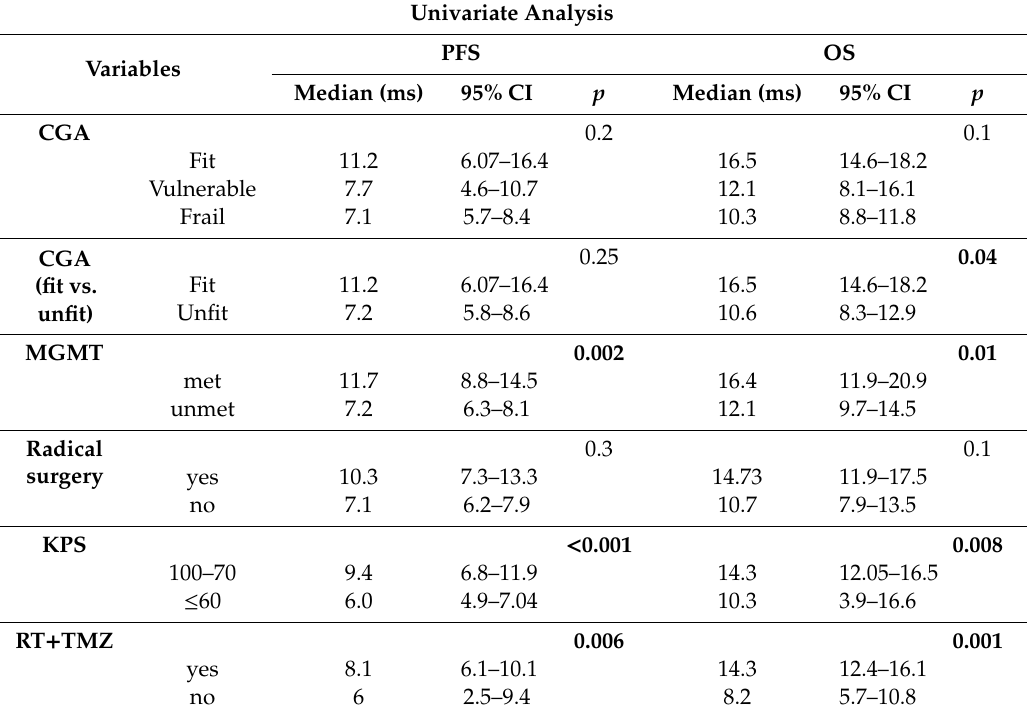
Table 3. Univariate analyses of clinical factors associated with progression-free survival (PFS) and OS. Univariate Analysis